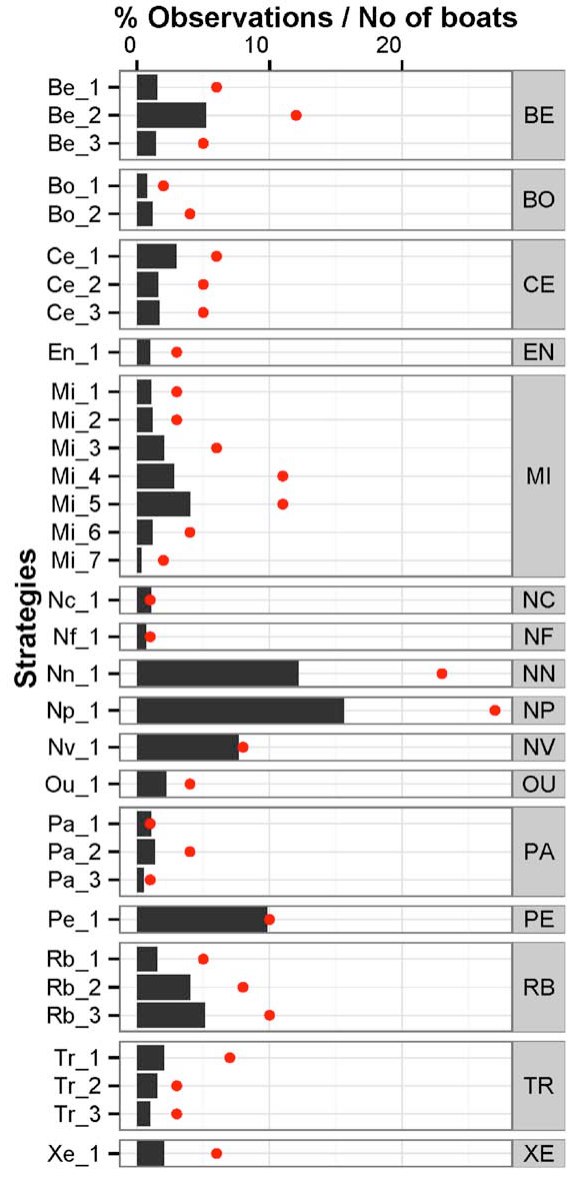
Fig. 3. – Use of the fishing strategies in the Cíes Islands (see Table 2 for the explanation of each strategy). Bars show the percentage of observations (strategy used per interviewed boat and month) belonging to each strategy. Dots show the number of interviewed boats that used a given strategy sometime in the